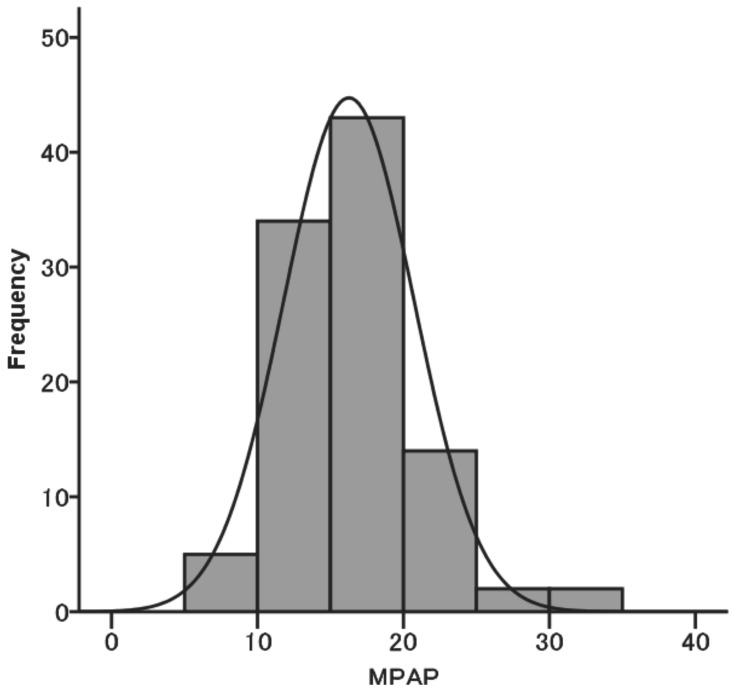
Histogram of MPAP.